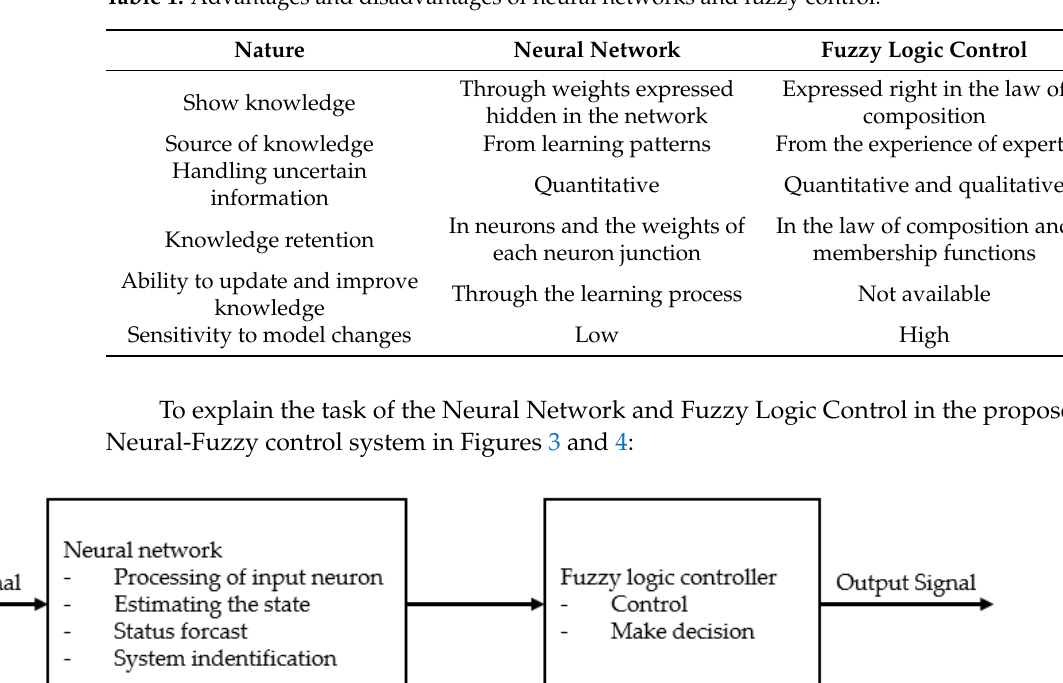
Figure 4. The block diagram of the Neural-Fuzzy system. In Figures 3 and 4, it is easy to see a neural fuzzy system is characterized by the use of neural networks to provide fuzzy systems with a kind of automatic tuning method, but without altering their functionality. In this study, connecting the fuzzy controller and neu- ral network is a form of serial coupling. This form of coupling is very suitable for problems where the neural network is responsible for processing input and output signals for fuzzy controllers. Neural networks have a major drawback of their “black box” nature. Data is fed into the network, computation occurs, and results are output. However, we don’t know exactly what happened. Fuzzy logic is the opposite, their rule sets are very close to human knowledge. How- ever, fuzzy logic does not have the self-learning ability of neural networks. Fuzzy rules and membership functions can only be adjusted manually. Therefore, the combination of neural networks and fuzzy control has invisibly elim- inated their shortcomings, creating a neural-fuzzy controller with outstanding ad- vantages. The following table shows the strengths and weaknesses of Neural networks and Fuzzy Logic Control. For the reasons mentioned above, the combination of these two con- trol methods is a perfect complement to each other. The new hybrid controller is more efficient and intelligent. The fuzzy neural system uses the learning algorithm of a multi-layer neural network to adjust the parameters and structure of the fuzzy set (Figures 5 and 6). This means that the fuzzy set can construct itself (without needing specialized knowledge of the object it models) when given a rich data set. The finished structure can easily be “compiled” into a human-friendly legal language. This is an effective combination of soft computing tech- nology.